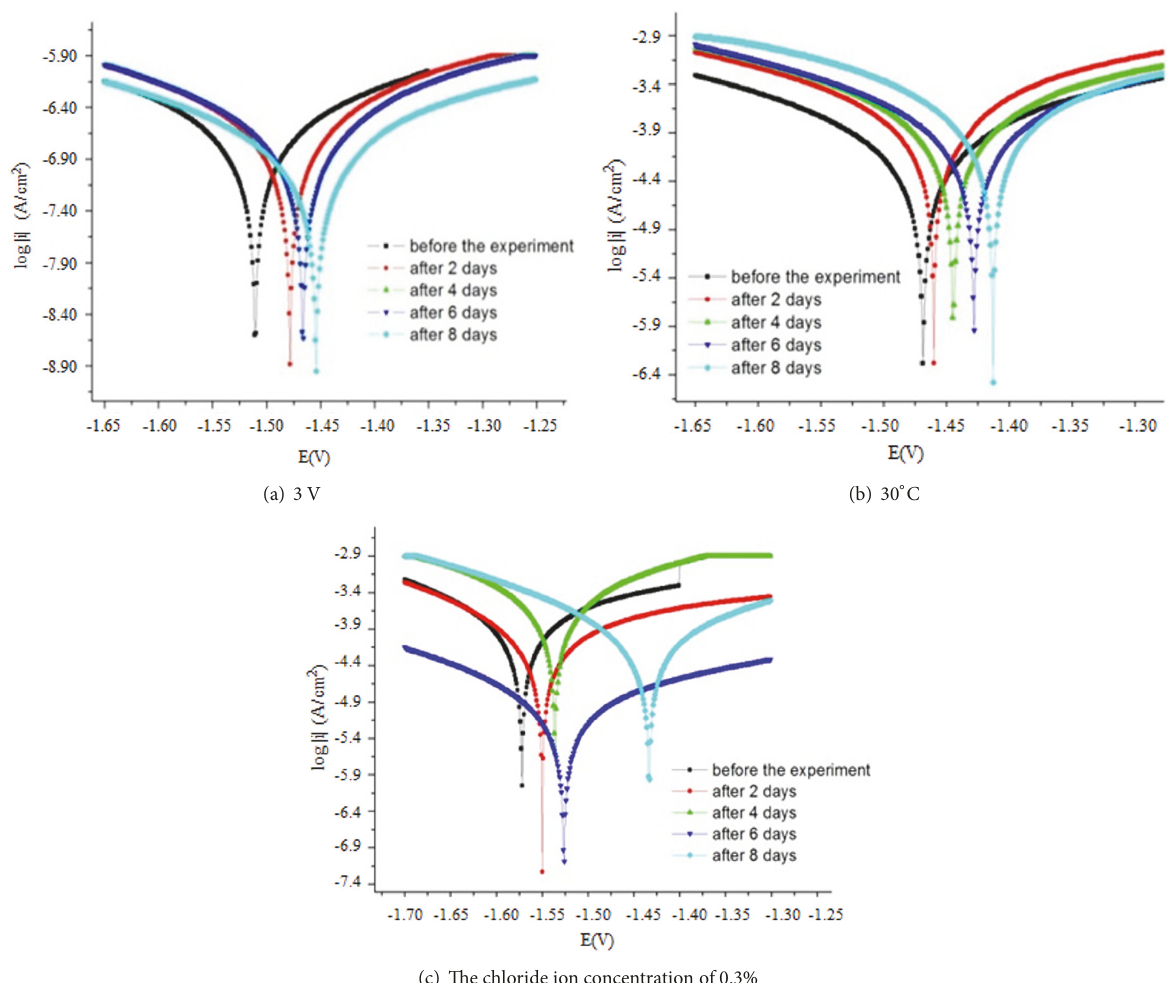
Figure 2: Polarization curves of magnesium sacrificial anode with different influence